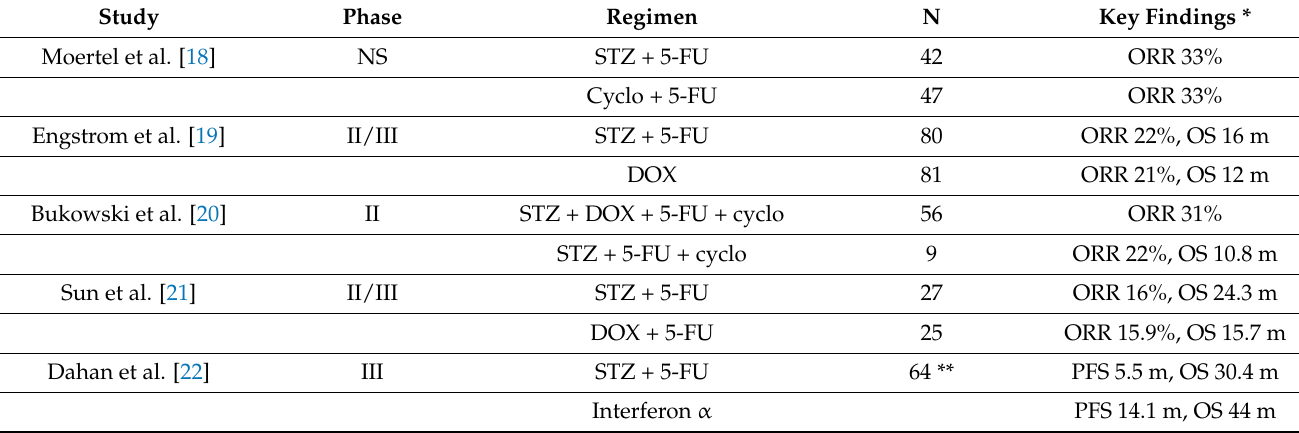
Table 1. A summary of prospective studies with streptozocin in patients with extra-pancreatic